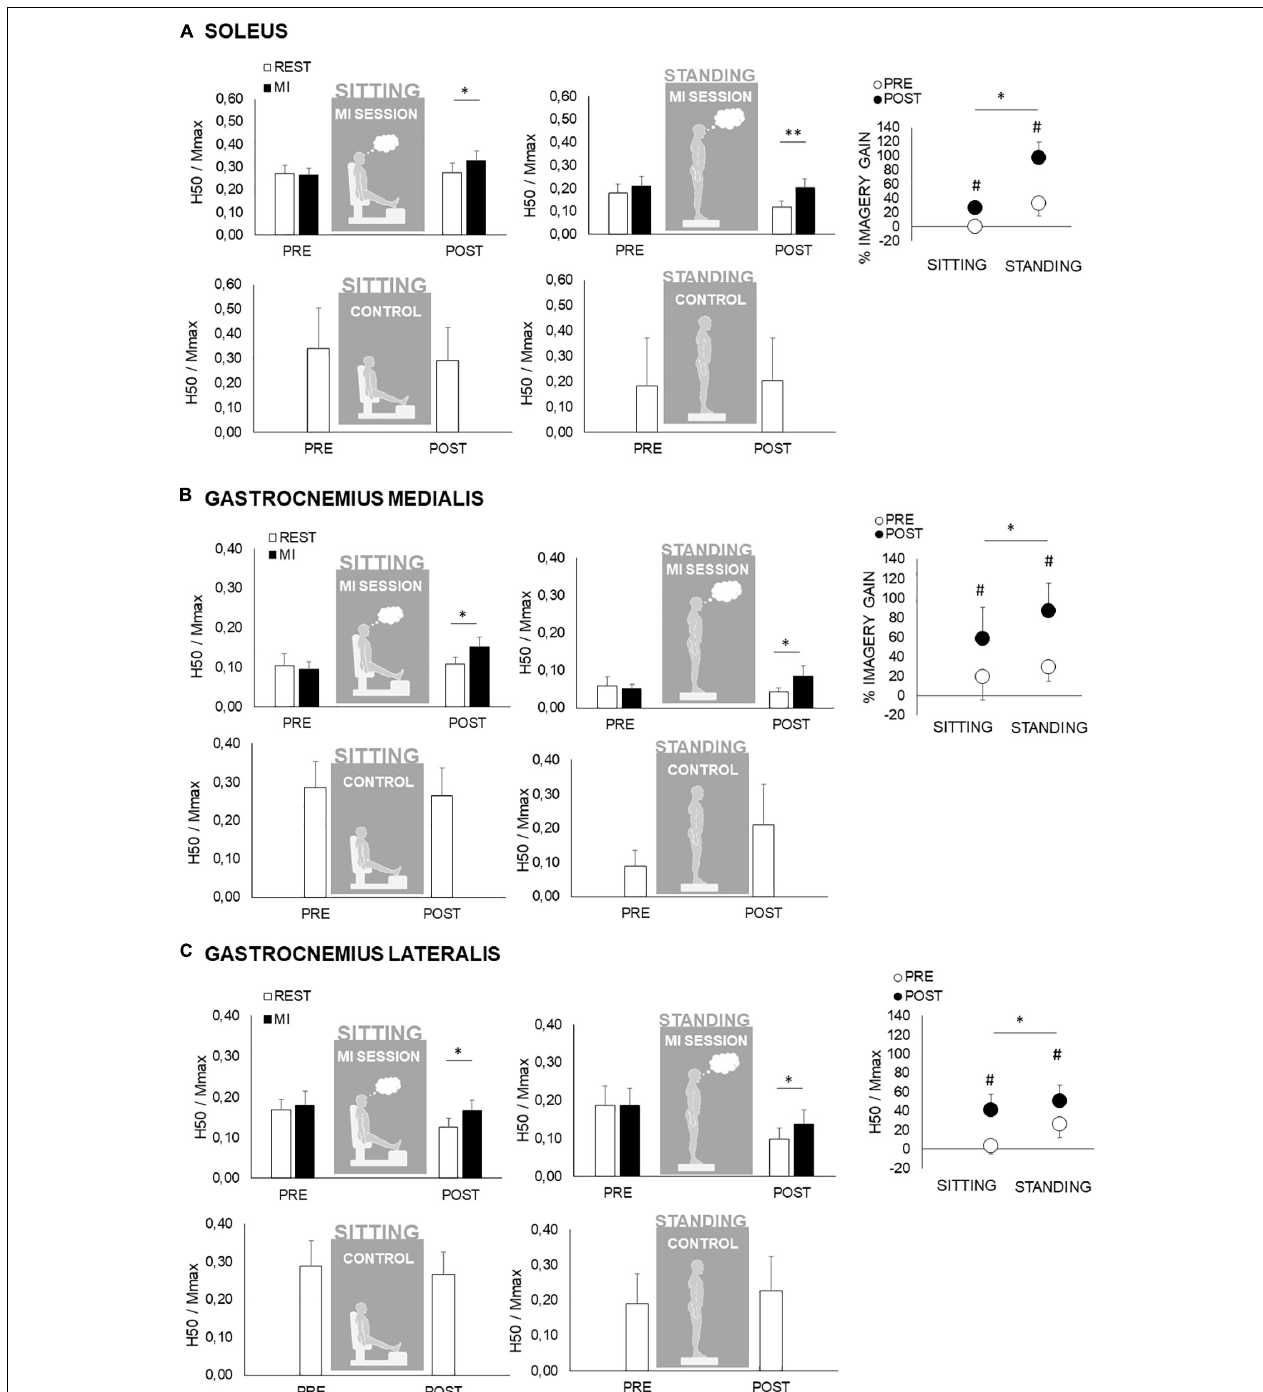
FIGURE 4 | Spinal excitabilities of the triceps surae during the motor imagery (MI) and control (CTRL) conditions in the sitting and standing postures. In panels (A–C) are depicted responses for soleus, gastrocnemius medialis and gastrocnemius lateralis, respectively. PRE and POST responses are recorded during rest (white bars) and during MI (black bars) in sitting (left panel) and in standing condition (middle panel). In panels (A–C) upper panels depict data of the motor imagery session and lower panels depict data of the CTRL session. Spinal excitabilities are measured by the H-reflex recorded at 50% of its maximal value (H 50 ). This response is normalized by the maximal muscle compound action potential (H 50 /M MAX ) recorded in the same condition (MI or rest). The right panel represent the gain associated to motor imagery in the mental session {determined by the formula [(MI-REST)/REST] × 100} in each condition from PRE (white circles) to POST (black circles). This gain is calculated according to the results obtained in H-reflexes in MI and at rest, depicted in the left panels. ∗ , ∗∗ : significant differences at p < 0.05 and p < 0.01, respectively. #: significant pre–post differences at p < 0.05 for the relative gains associated to MI.